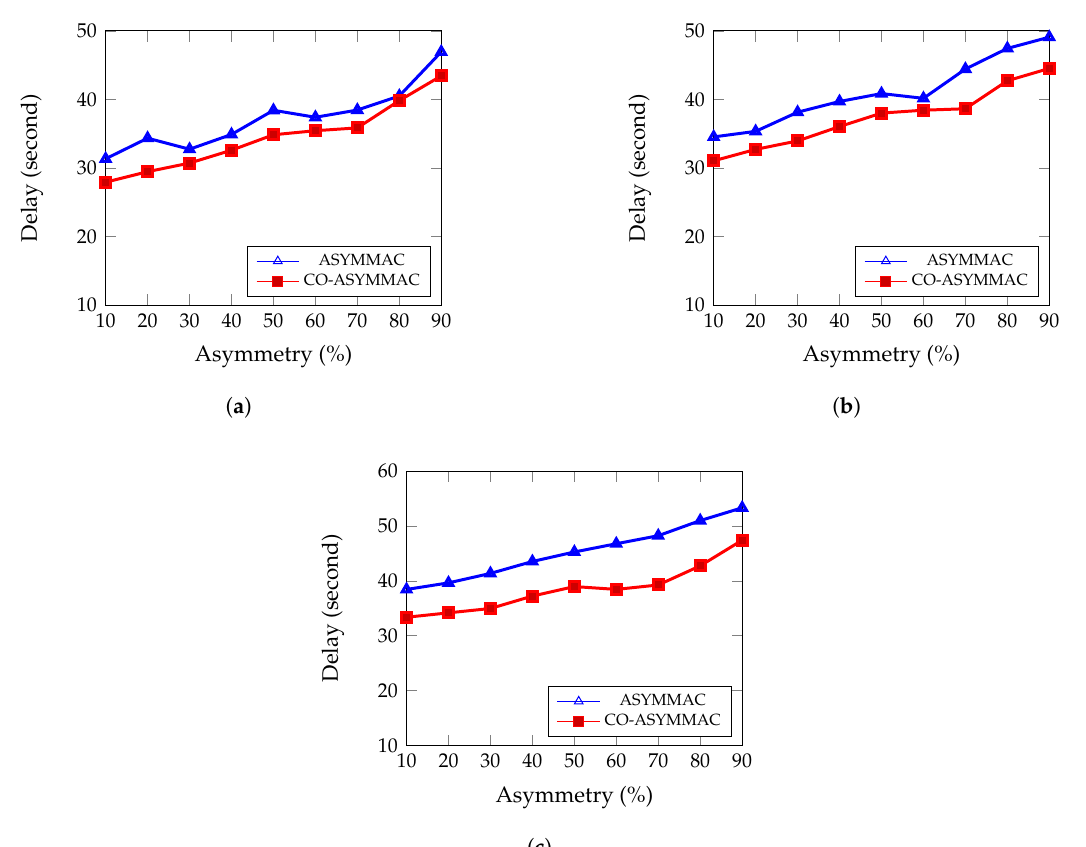
Figure 13. Average delay per packet: ( a ) for 27 nodes; ( b ) for 54 nodes; and ( c ) for 90